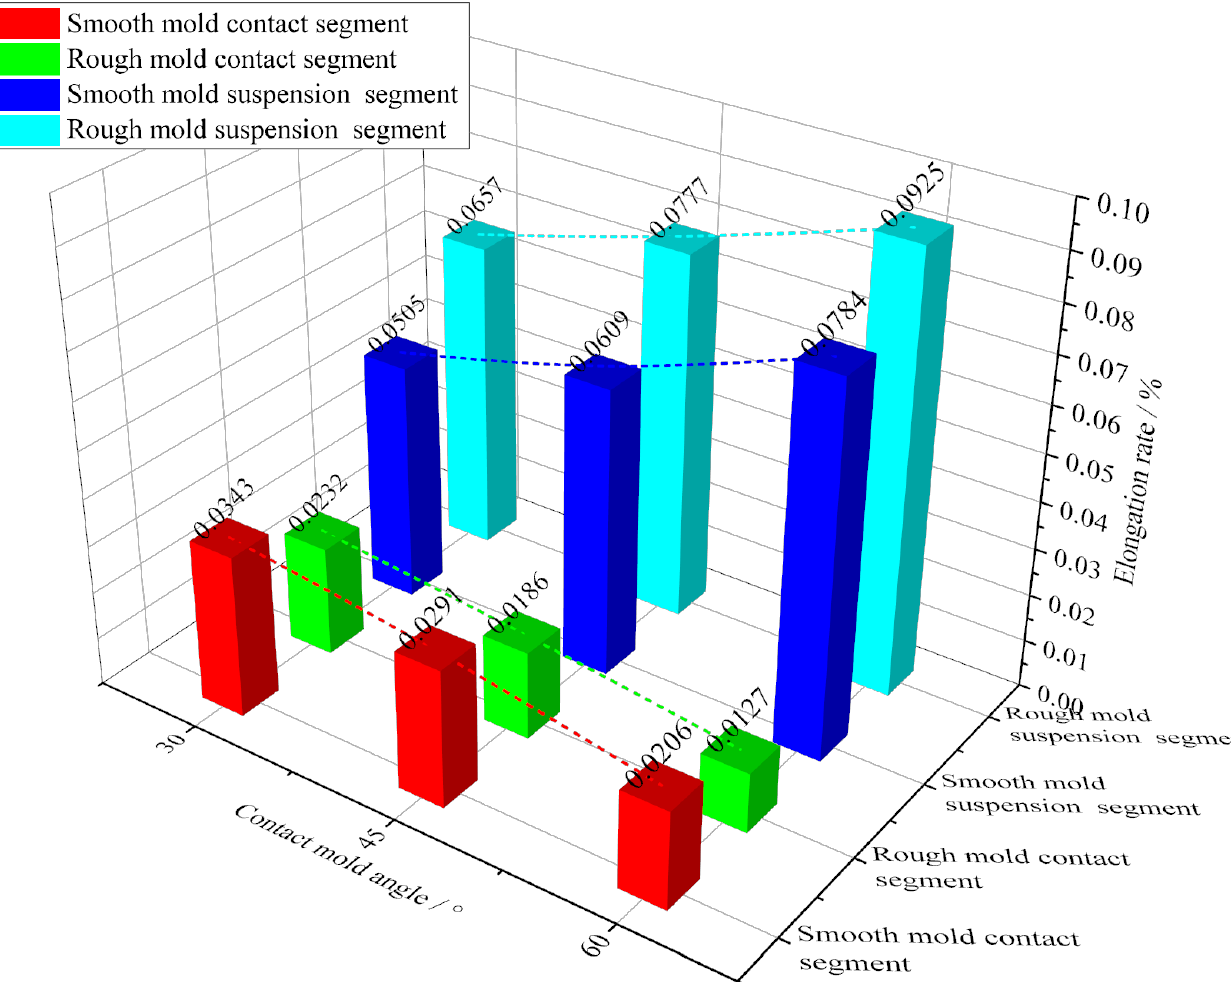
Figure 18. The tensile elongation distribution of the contact mold segment and the suspension segment with different contact mold angle.